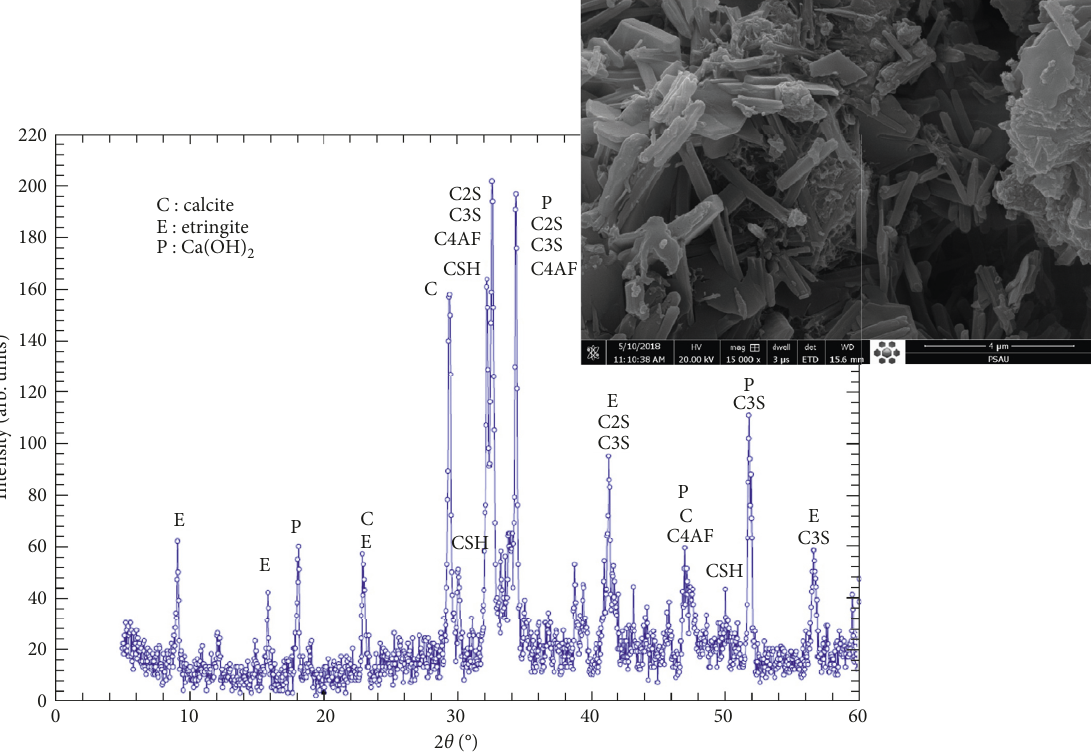
Figure 7: SEM micrographs and XRD pattern of cement paste.